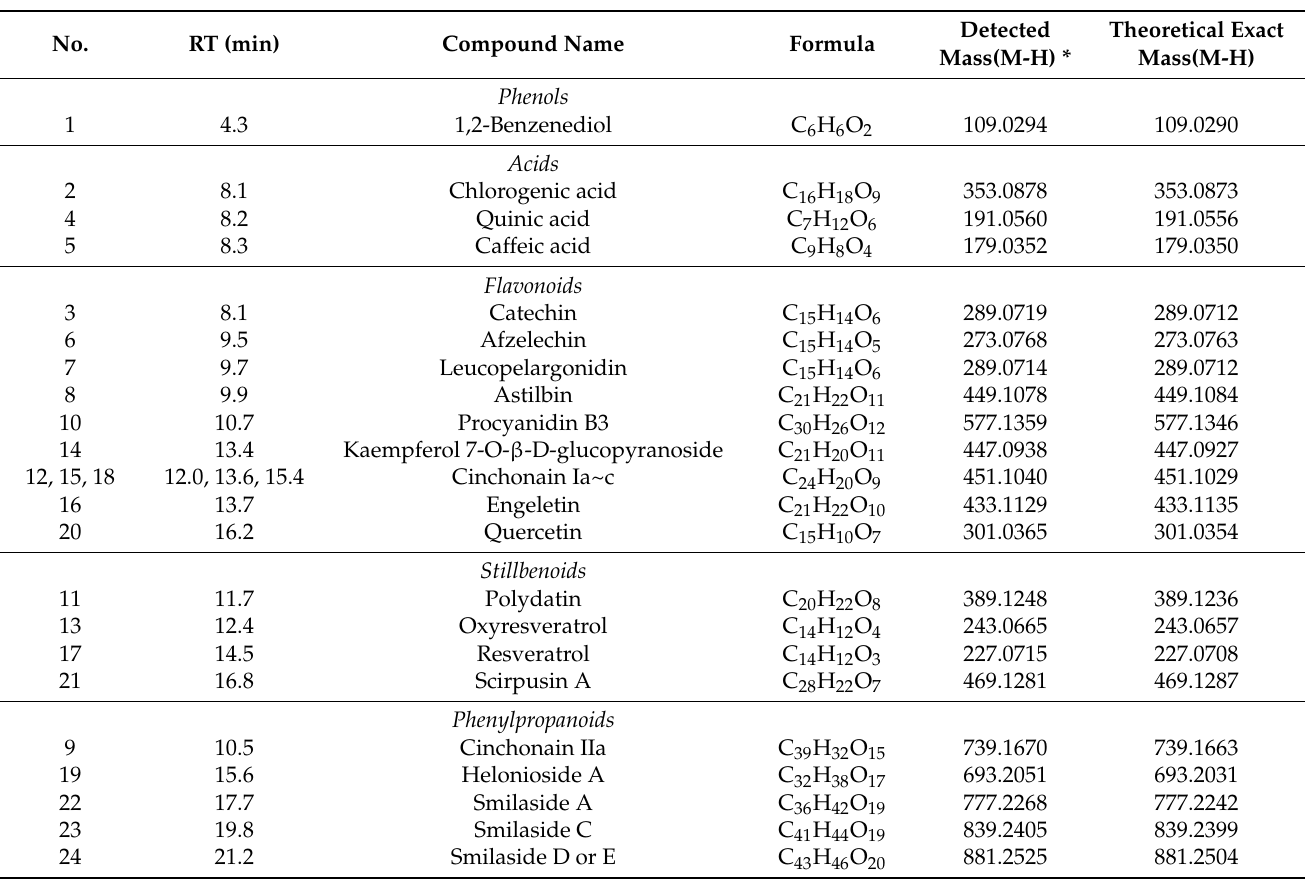
Figure 2. LC/QTOF/MS chromatogram showing natural products from ethyl acetate-soluble fraction of Smilax china L. root extract. Table 1. Compounds identified from ethyl acetate-soluble fraction of Smilax china L. root extract.